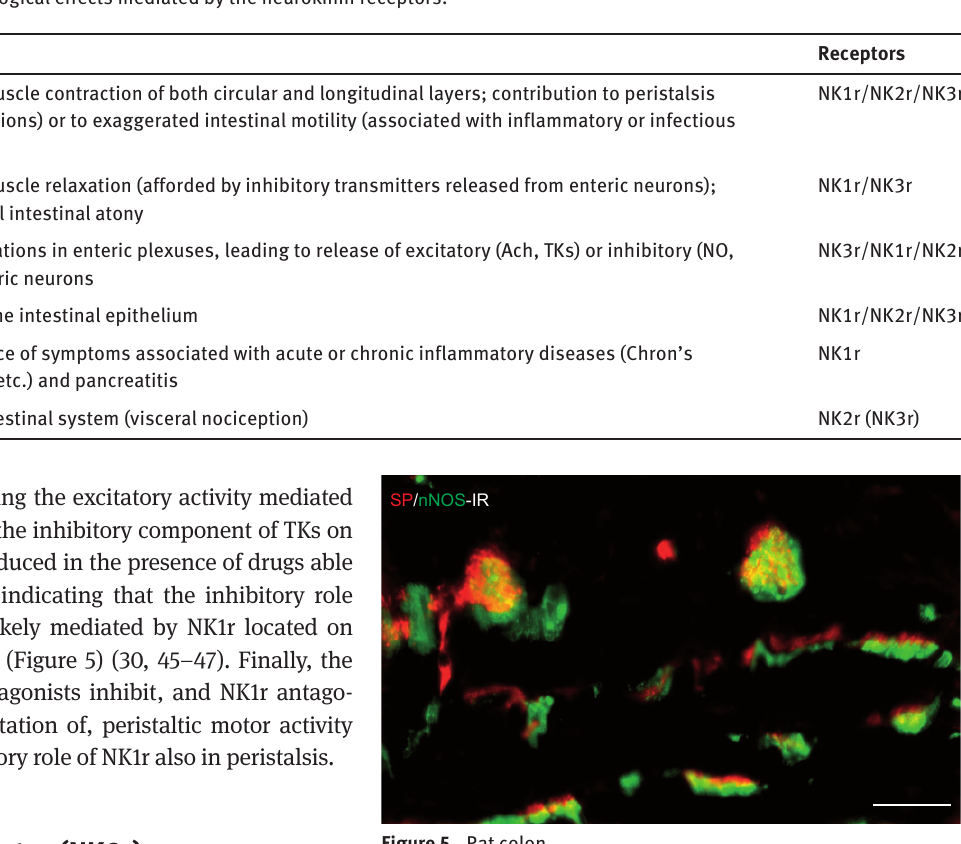
Table 1 Main pathophysiological effects mediated by the neurokinin receptors.